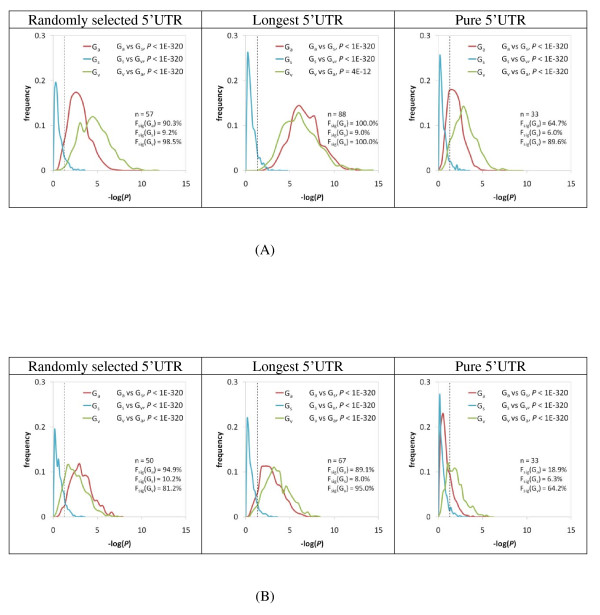
Distributions of the P values in different ISI comparisons by controlling the sample sizes (indicated by "n") of Gs and Gv transcripts to be the same as those of the Ga transcripts. One thousand times of re-sampling with replacement was performed for each transcript subgroup to derive the P value distributions. The P values were estimated by using the Mann-Whitney U test. The dashed line indicates P = 0.05 (or -log (P) = 1.301). "Fsig" indicates the fraction of P values in the distribution that is smaller than 0.05. The statistical significance between P value distributions of different transcript subgroups was estimated by using the Kolmogorov-Smirnov test and shown in the upper right corner of each panel.